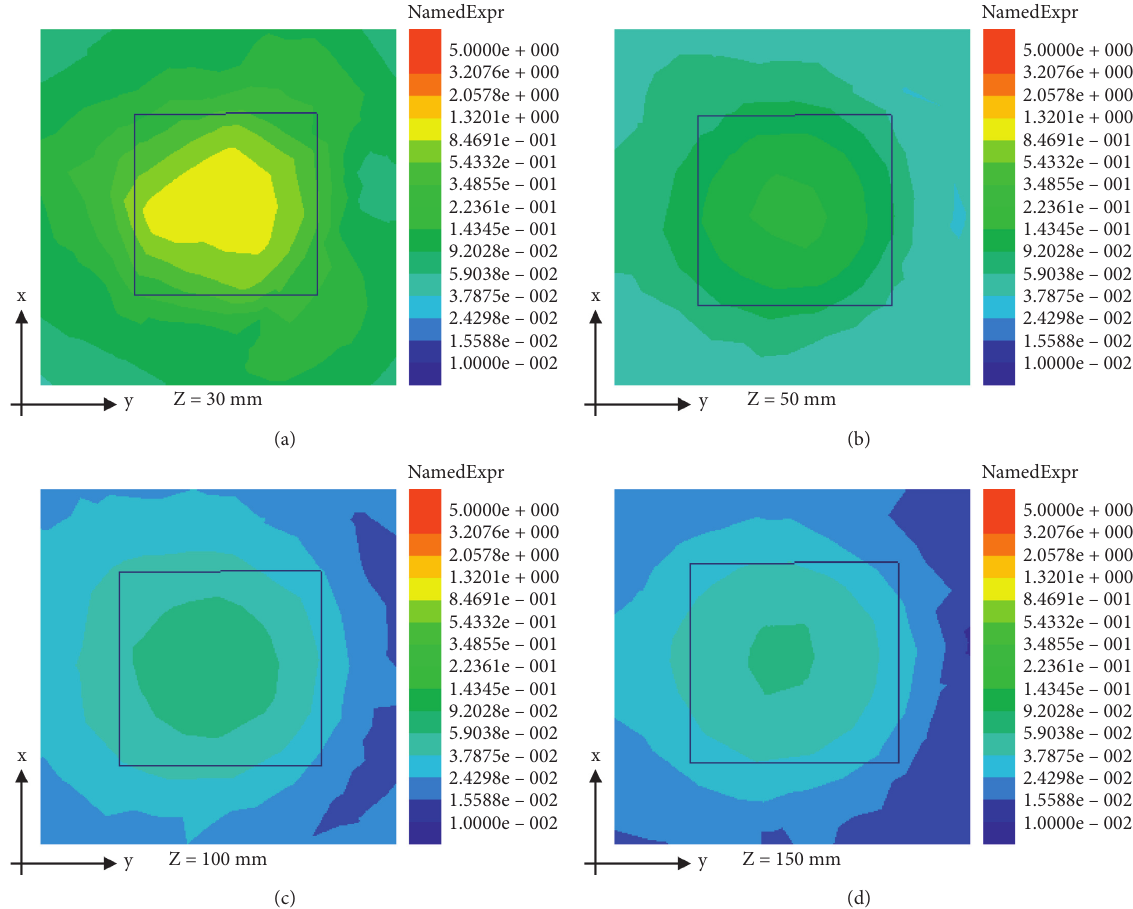
Figure 13: Simulated Ez distributions of the three-branch antenna at different heights when the substrate thickness h � 0.5mm. (a) Z � 30 mm. (b) Z � 50mm. (c) Z � 100mm. (d) Z �